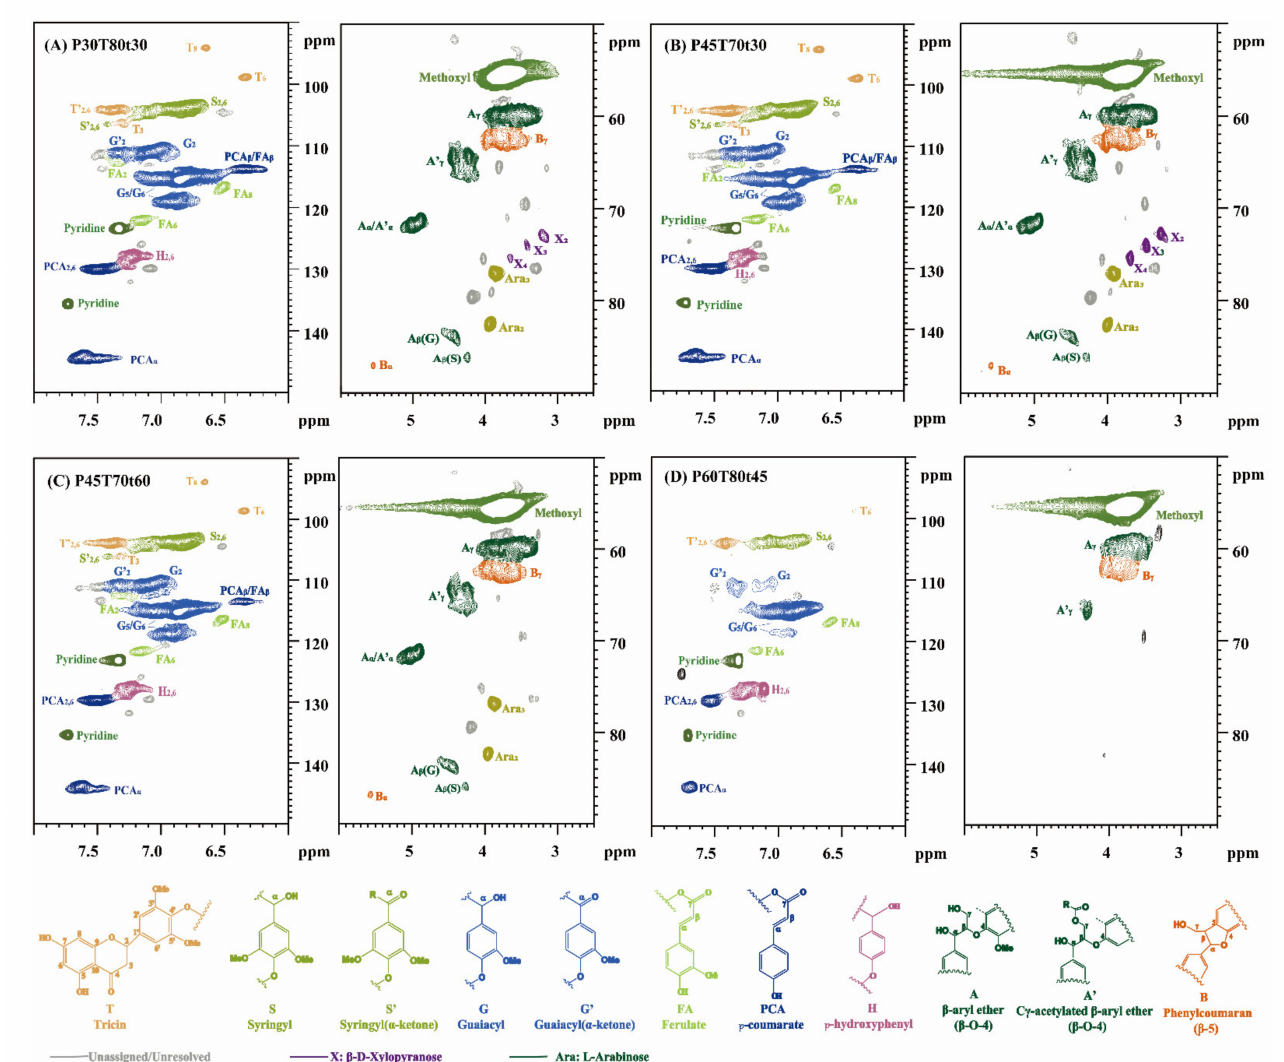
Figure 8. 2D 13 C- 1 H NMR HSQC spectra of selected lignin samples: ( A ) P30T80t30; ( B ) P45T70t30; ( C ) P45T70t60; ( D )